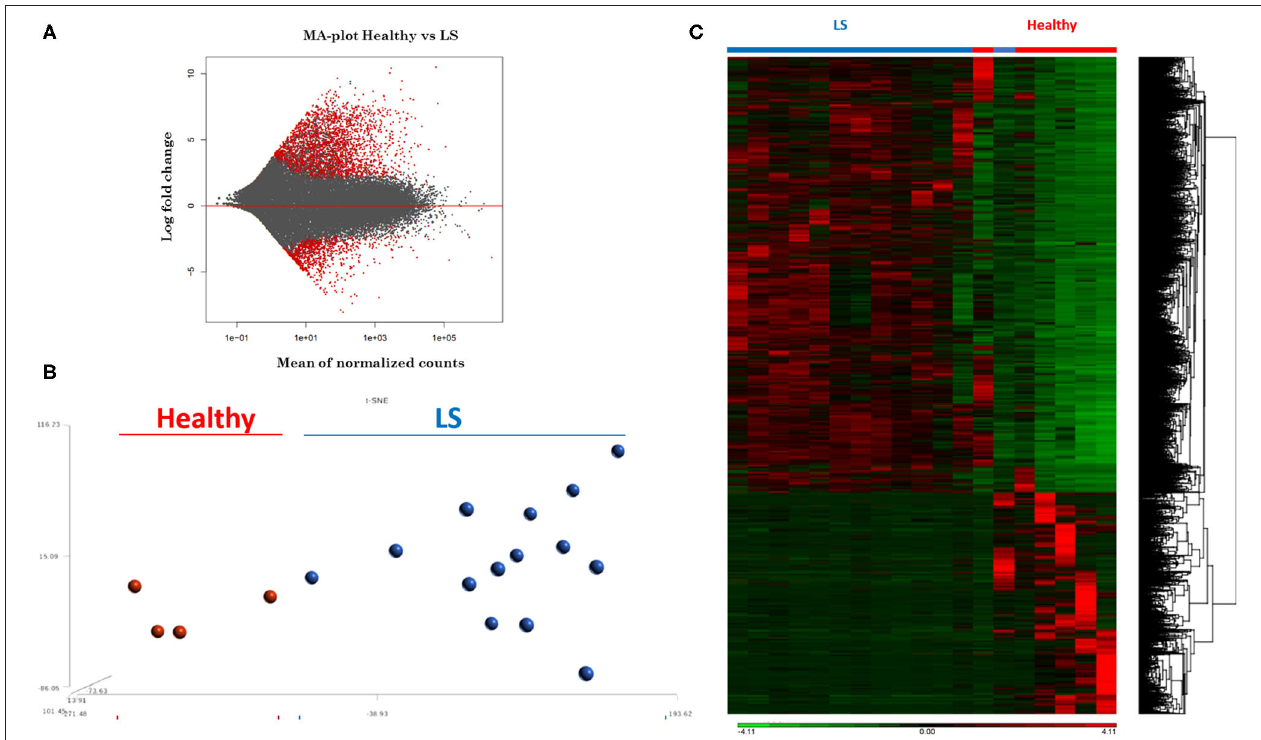
FIGURE 3 | RNAseq expression differences between healthy and localized scleroderma (LS) subject samples. (A) Intensity-dependent ratios between two groups of data. Red points denote genes with significant differences. (B) tSNE clustering of genetic expression confirms significant differences between the two data groups. (C) Heat map showing the overall expression difference between all DEGs comparing LS to healthy